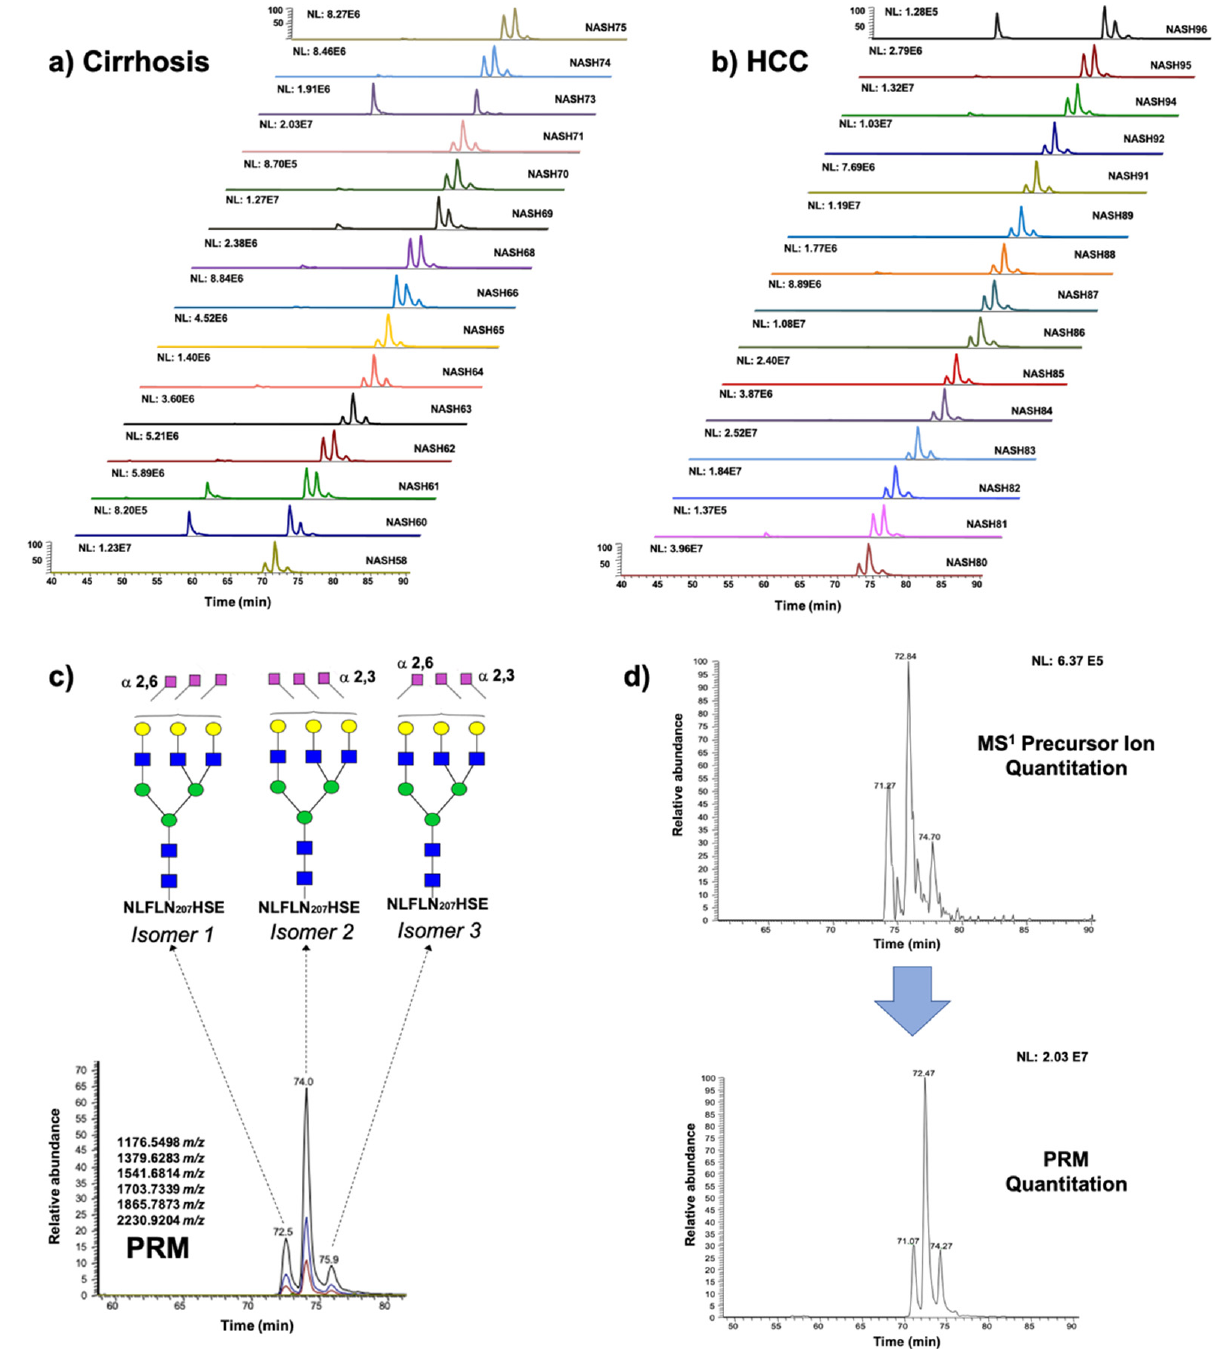
Figure 2. EICs for the glycopeptide structure NLFLN207HSE + HexNAc 5 Hex 6 Neu5Ac 3 derived from ( a ) cirrhosis and ( b ) hepatocellular carcinoma patients; ( c ) PRM quantitation of the glycopeptide structure and sialic acid linkage of the isomeric glycan moieties; ( d ) EICs for the glycopeptide structure NLFLN207HSE + HexNAc 5 Hex 6 Neu5Ac 3 , 1278.8295 m / z . Sensitivity difference between full-scan MS ion extraction and PRM approach.